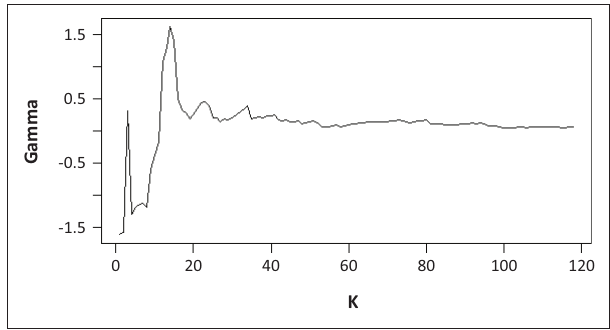
Weighted ARCH LM